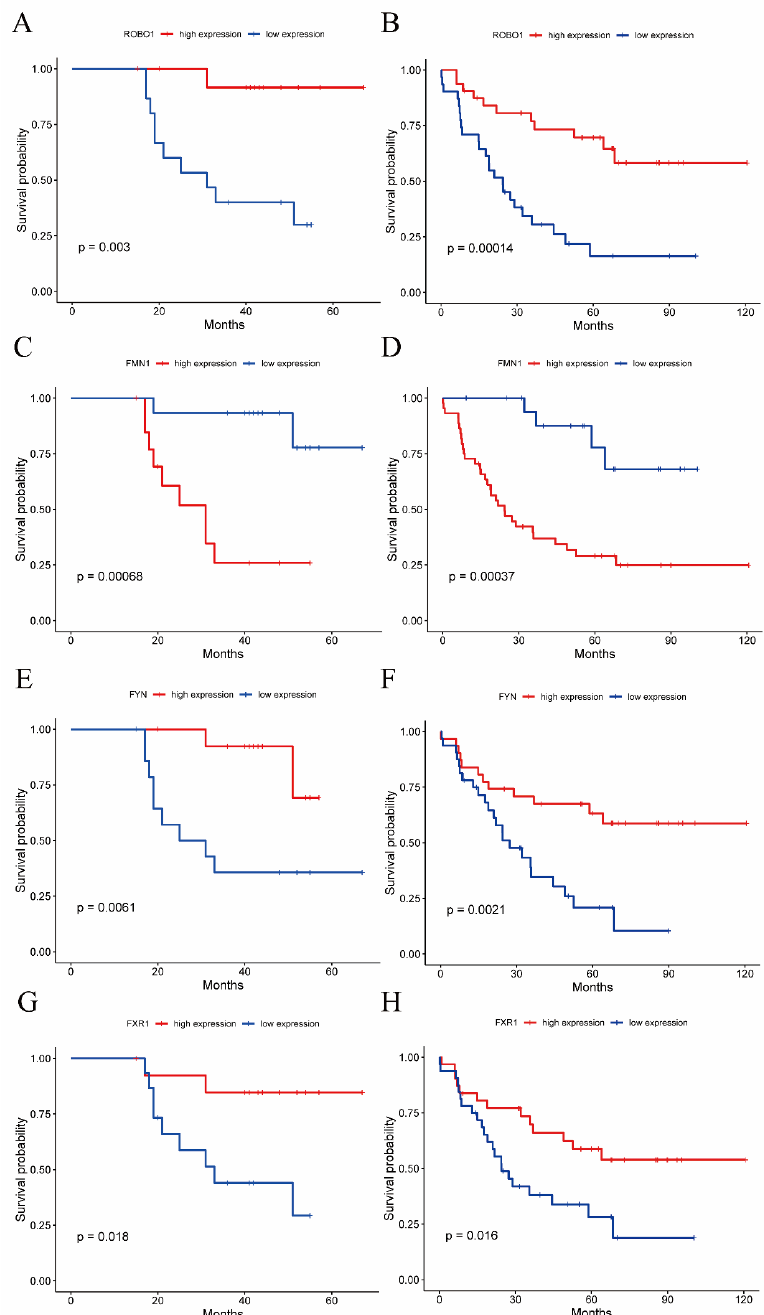
Figure 6. Kaplan–Meier curves of GSE27831 and GSE22138. ( A ) Kaplan–Meier curves of GSE27831, divided into two groups using the median ROBO1 expression levels as the boundary. ( B ) Kaplan– Meier curves of GSE22138, divided into two groups using the median ROBO1 expression levels as the boundary. ( C ) Kaplan–Meier curves of GSE27831, divided into two groups using the median FMN1 expression levels as the boundary. ( D ) Kaplan–Meier curves of GSE22138, divided into two groups using the median FMN1 expression levels as the boundary. ( E ) Kaplan–Meier curves of GSE27831, divided into two groups using the median FYN expression levels as the boundary. ( F ) Kaplan–Meier curves of GSE22138, divided into two groups using the median FYN expression levels as the boundary. ( G ) Kaplan–Meier curves of GSE27831, divided into two groups using the median FXR1 expression levels as the boundary. ( H ) Kaplan–Meier curves of GSE22138, divided into two groups using the median FXR1 expression levels as the